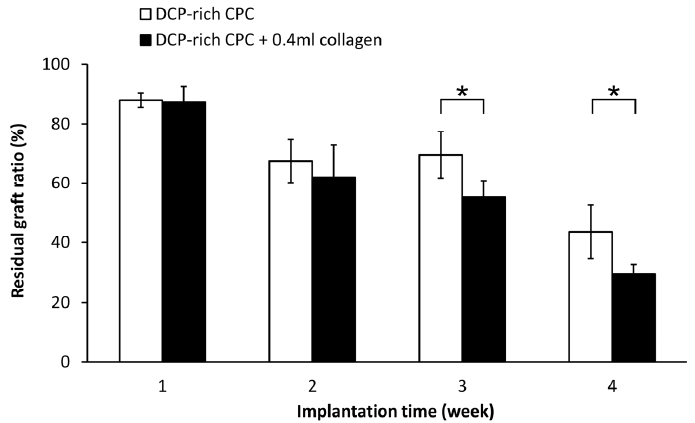
Figure 6. The comparison of residual graft ratio among two groups ( n = 3). * p < 0.01.